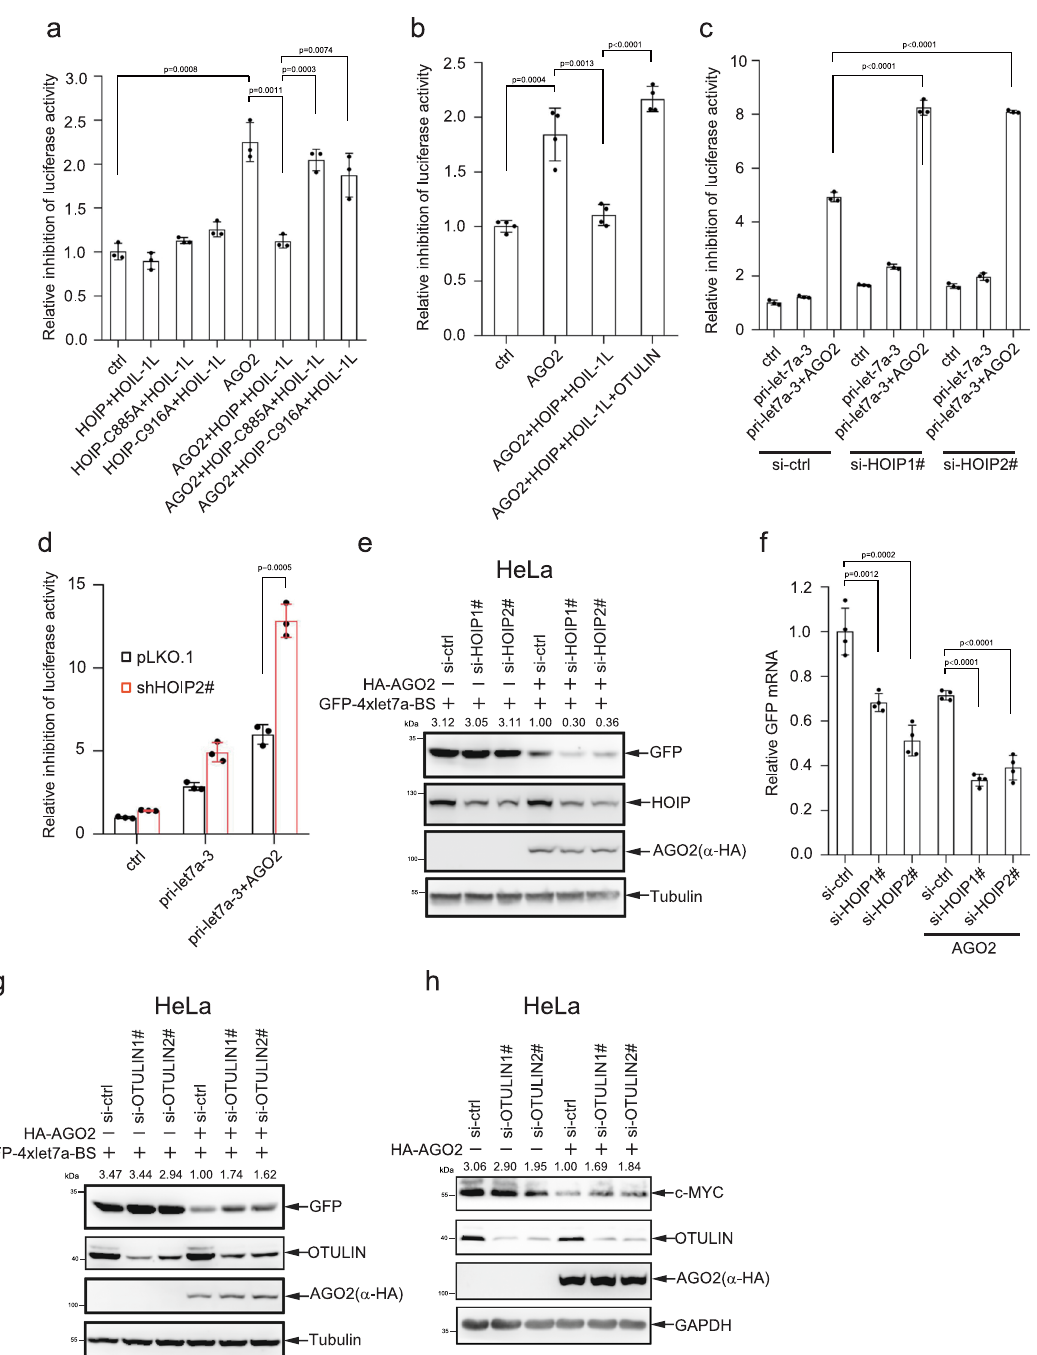
Fig. 5 M1-Ubi of AGO2 inhibits the miRISC activity. a HOIP/HOIL-1L, but not HOIP-C885A/HOIL-1L and HOIP-C916A/HOIL-1L reduced the inhibition of luciferase activity mediated by AGO2. b OTULIN recovered the reduced inhibition of luciferase activity by LUBAC. c , d Knockdown HOIP by siRNAs in 293T cell ( c ) or by shRNA in HeLa cell ( d ) increased the inhibition of luciferase activity mediated by AGO2. 293T cells ( a – c ) or HeLa-shHOIP cells ( d ) transfected with indicated plasmids were harvested for the psiCHECK2-4xlet-7a-BS of dual-luciferase assay. Dual-luciferase reporter assay data were mean ± s.e.m., n = 3 ( a , c , d ) or n = 4 ( b ) biologically independent experiments, and P -values were determined by unpaired two-sided t-test. e , f Knockdown of HOIP increased let-7a-targeted GFP protein and mRNA levels. HeLa cells were transfected with indicated plasmids and siRNAs, the GFP protein expression was detected by WB ( e ). 293T cell stably expressing GFP-4x-let-7a-BS was transfected with HOIP siRNAs, and then total RNAs were extracted for detection of GFP mRNA levels by qRT-PCR. Data were mean ± s.d., n = 4 biologically independent samples, and P -values were determined by unpaired two-sided t-test ( f ). g , h Knockdown of OTULIN decreased let-7a-targeted GFP and c-MYC decay. HeLa cells were transfected with indicated plasmids and siRNAs, the proteins GFP ( g ) and c-MYC ( h ) expression were measured by WB